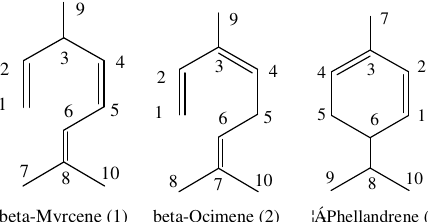
Figure 1. Compounds isolated from Evodia rutaecarpa essential